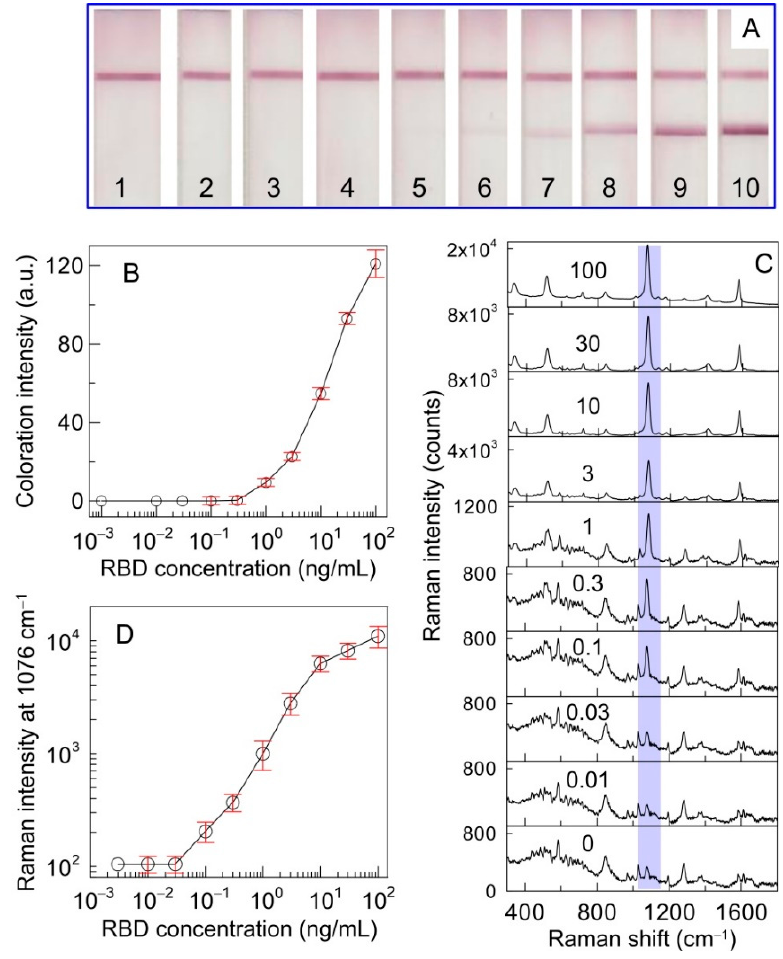
Figure 4. ( A ) Photographic images of LFIA strips after application of RBD at concentrations 0 (1), 0.01 (2). 0.03 (3), 0.1 (4), 0.3 (5), 1 (6), 3 (7), 10 (8), 30 (9), and 100 ng/mL (10). The top and bottom lines correspond to the control and test zones, respectively. ( B ) Calibration curve obtained after conventional LFIA procedure using SERS nanotags. The error bars indicate the STD for three measurements; ( C ) SERS spectra measured in the test line for RBD concentrations from 0.01 to 100 ng/mL. ( D ) Calibration curve of SERS-LFIA for RBD. The bars show the STD of the Raman signal at 1076 cm − 1 , measured from three independent SERS-based LFIA runs.